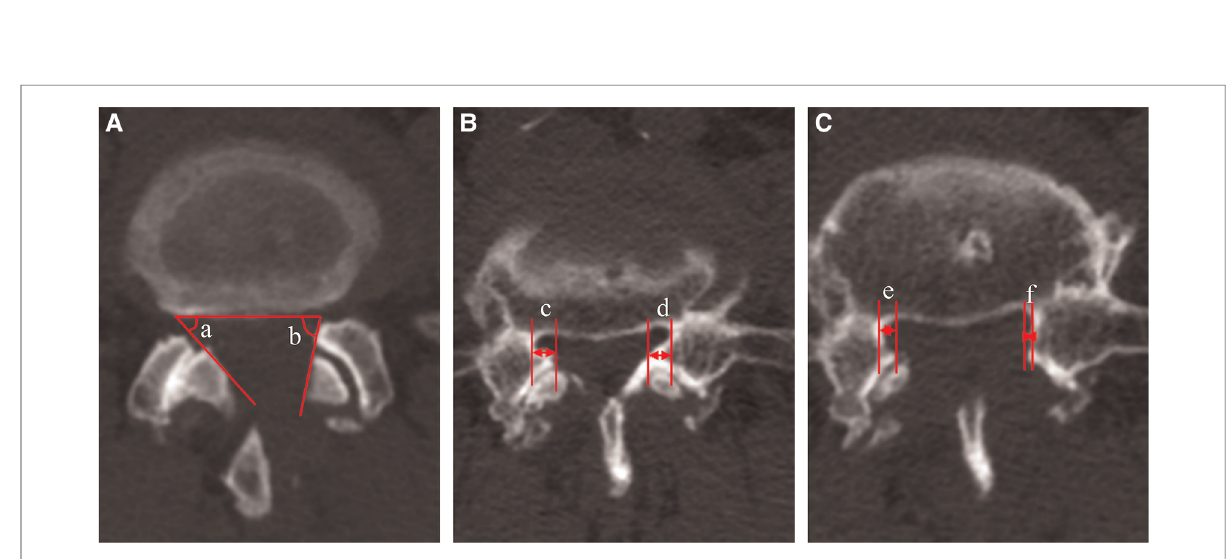
FIGURE 5 Measurement of resection angle of facet joint and decompression rate under CT. ( A ) Resection angle of facet joint, ( a ) contralateral side, ( b ) ipsilateral side; ( B ) The preoperative distance from the inner edge of the superior articular process to the inner edge of the pedicle, ( c ) contralateral side, ( d ) ipsilateral side; ( C ) The postoperative distance from the inner edge of the superior articular process to the inner edge of the pedicle, ( e ) contralateral side, ( f ) ipsilateral